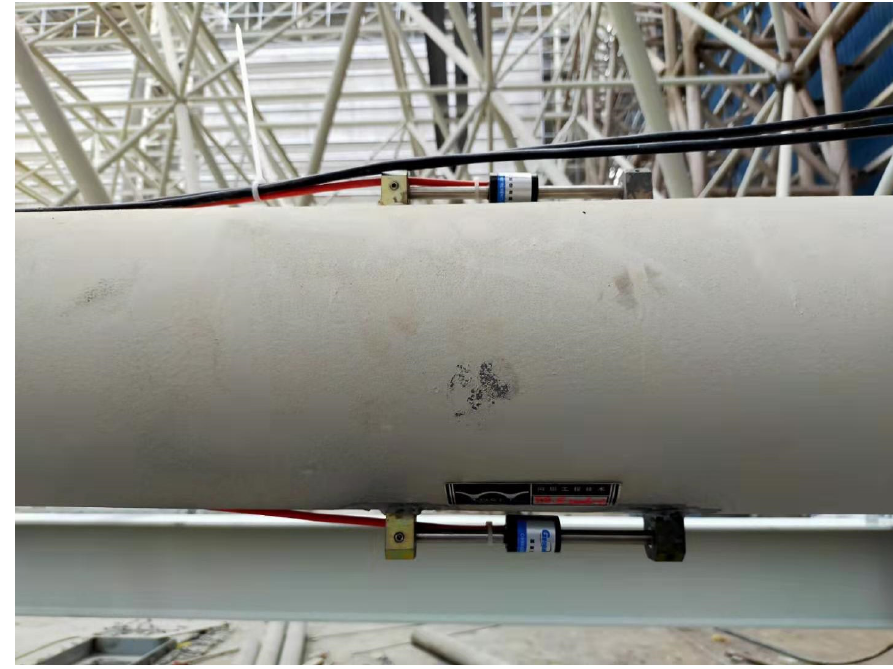
Figure 7. A vibrating wire surface strain gauge.